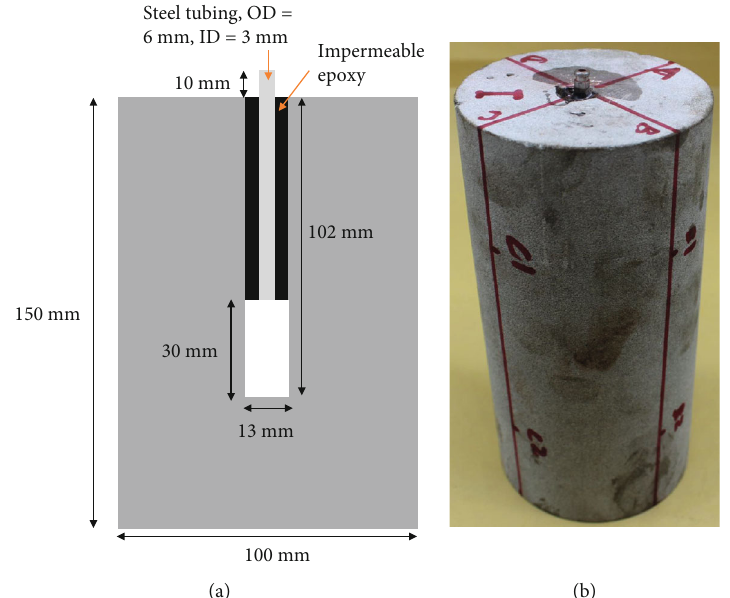
Figure 2: (a) Schematic of the vertical borehole drilled in each rock specimen for the fi rst batch of sandstone. (b) Picture of one specimen from the second batch of sandstone (diameter: 100mm; height: 190mm).